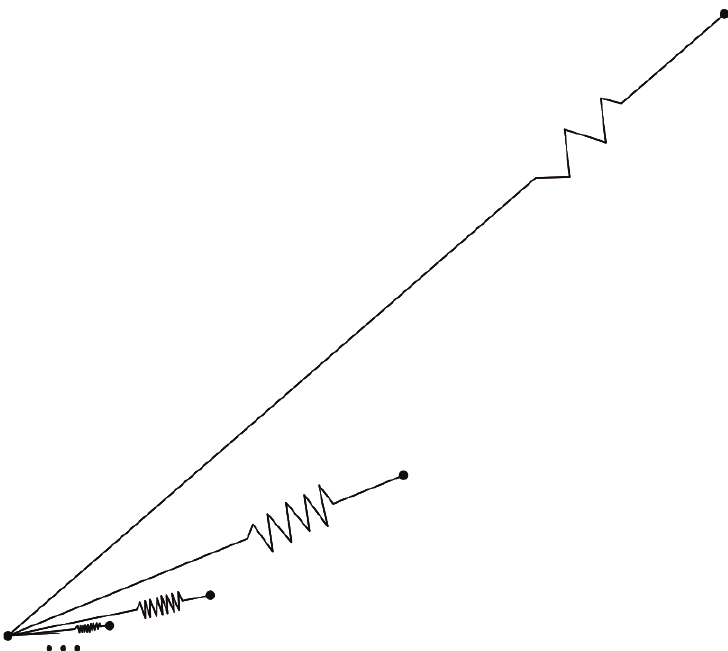
Figure 2. The space